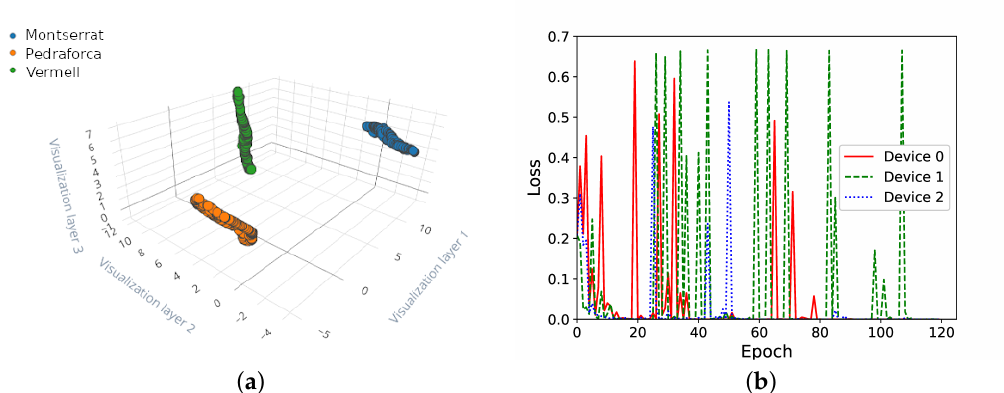
Figure 5. On-device training of the two keywords Montserrat and Pedraforca, without federated learning. ( a ) Separation of the three keywords. ( b ) Loss vs. epoch during training (1 sample for 1